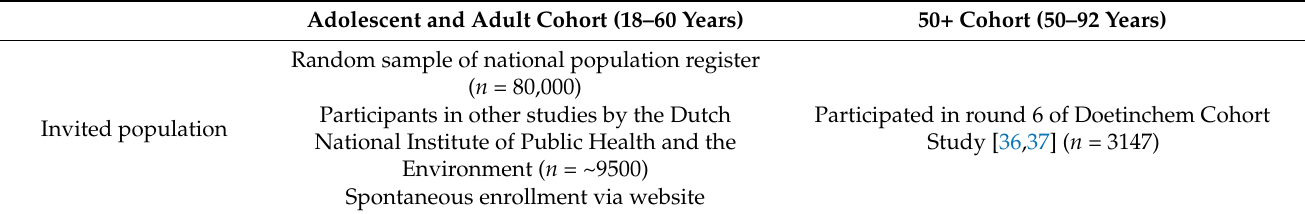
Table A1. Overview of study population, inclusion and exclusion criteria, and period of enrolment per